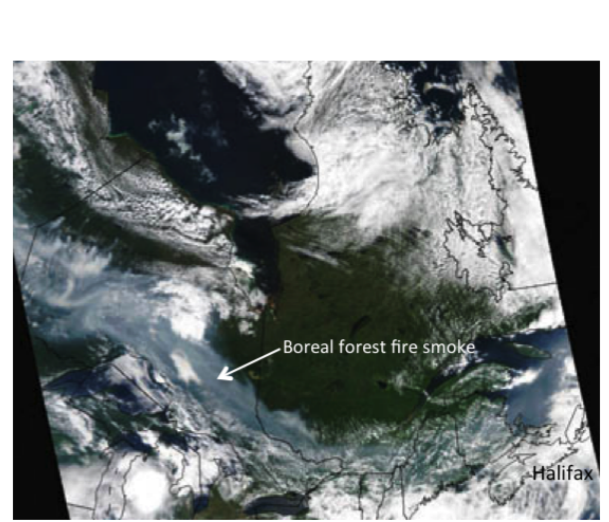
Figure 6. NASA AQUA MODIS true-colour satellite image at 18:00UTC on 18 July 2011 clearly showing boreal forest fire smoke from northern Ontario advecting over Halifax, Nova Scotia.